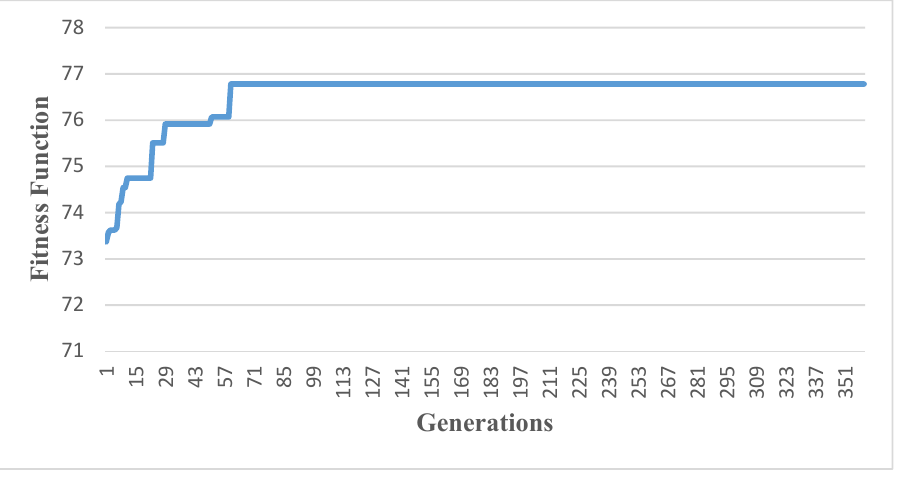
Figure 2. Fitness function with generations. Table 2. Number of times a feature is selected year-wise.